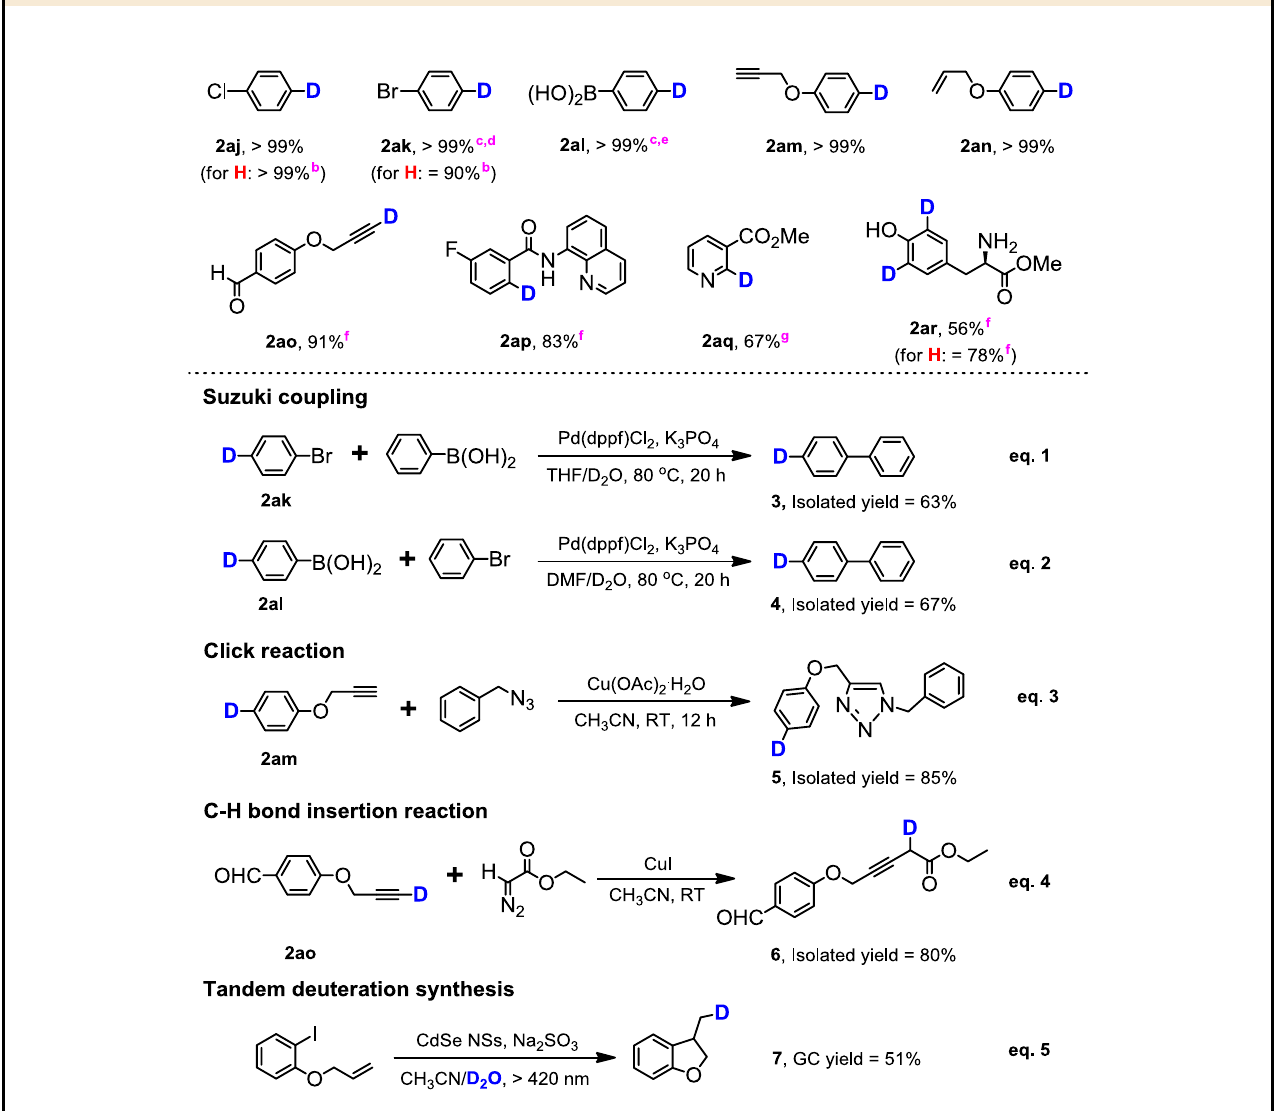
Table 2 D-labeled tools box from photocatalytic C – I to C – D tansformation